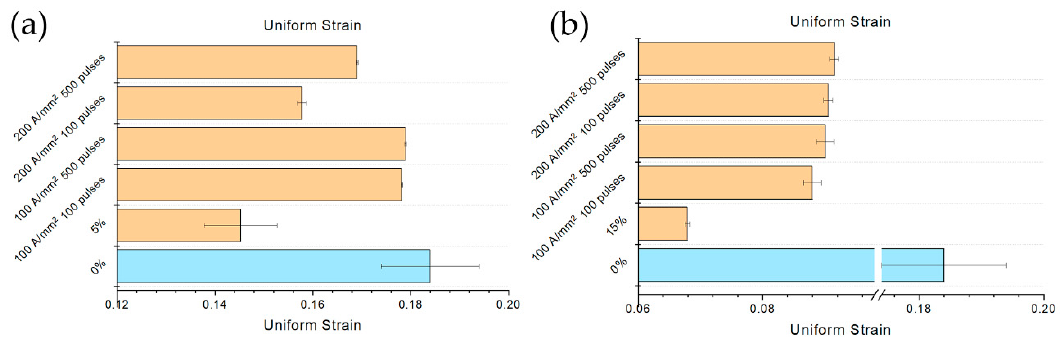
Figure 14. Evolution of uniform strain with respect the different electropulsing treatments and reference ( a ) 5% prestrained specimens and ( b ) 15% prestrained specimens.